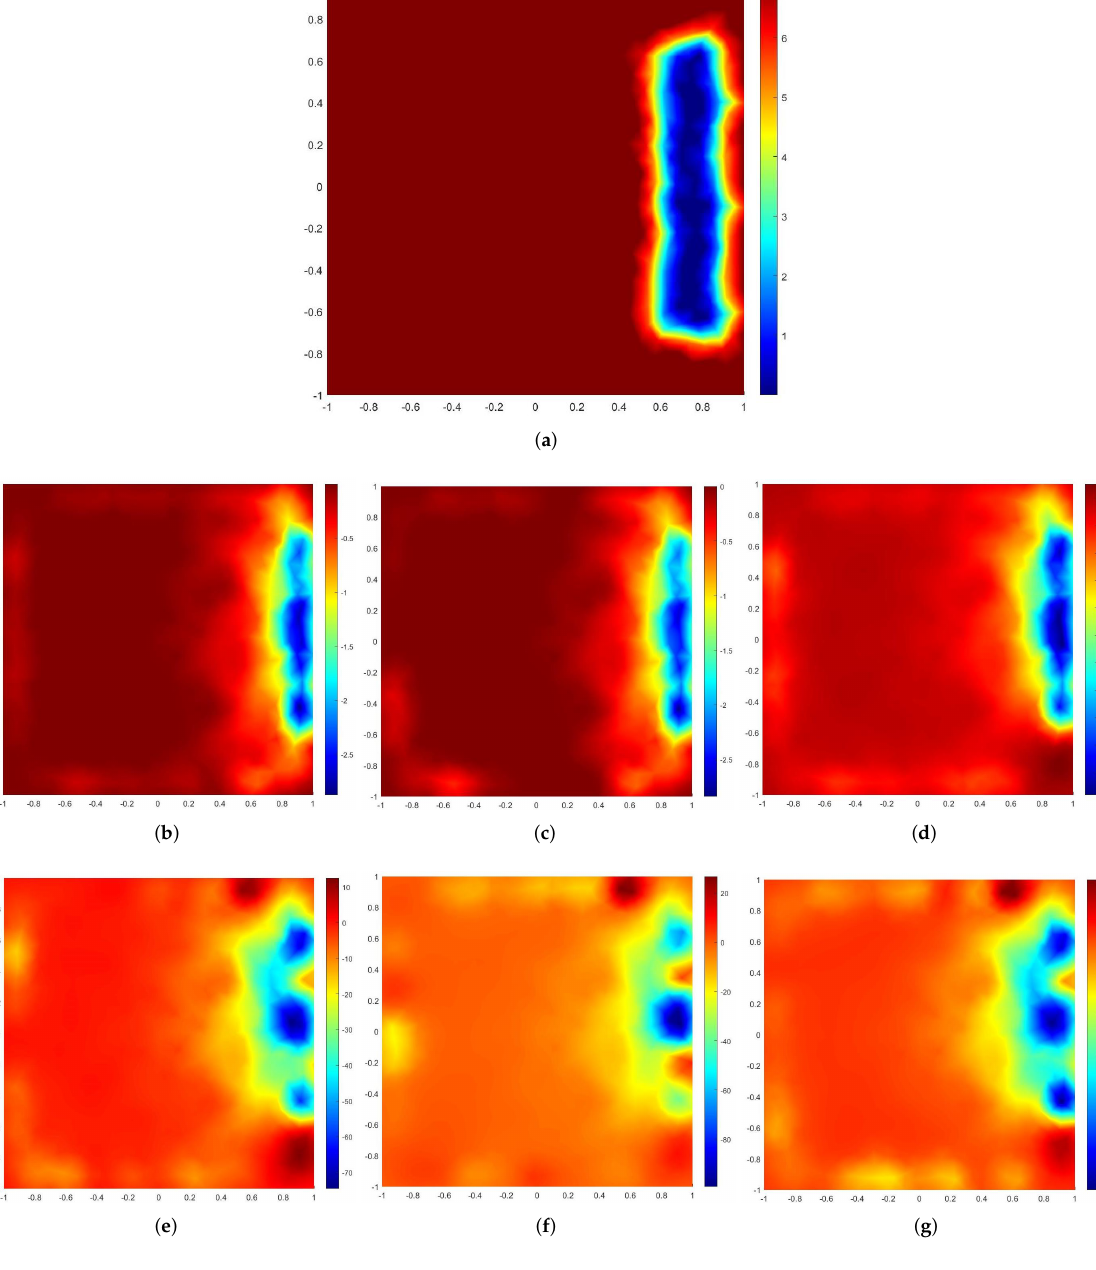
Figure 2. Example 2. ( a ) True resistive distribution. ( b – d ) Solution by TV-MMIRGN (second row); ( e – g ) reconstructions by IRGN (third row) at noise levels 1%, 2%, and 5% from left to right,